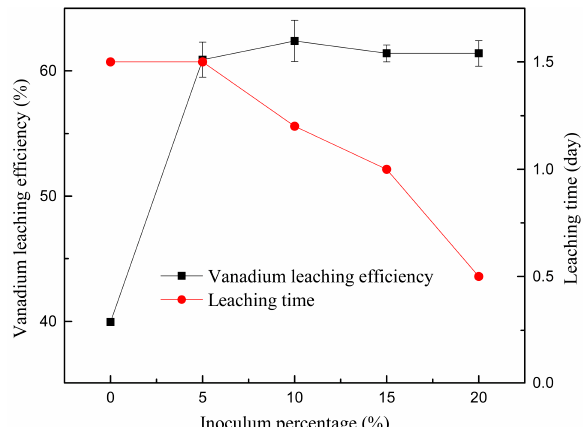
Figure 6. The highest vanadium leaching efficiency over time and the time needed for vanadium leaching efficiency to reach their maximum at different inoculum percentage.